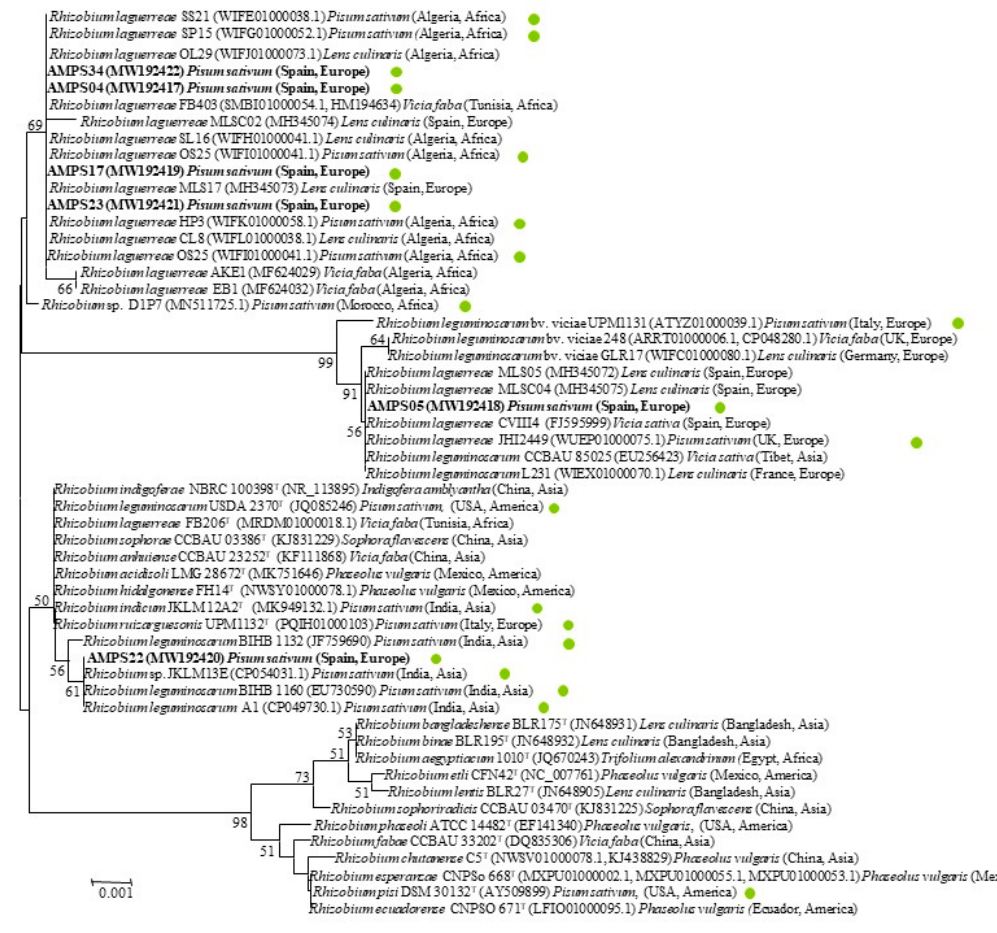
Figure2. Neighbor-joiningunrootedphylogenetictreebasedon rrs genesequences(1340nt)showingthe Figure 2. Neighbor-joining unrooted phylogenetic tree based on rrs gene sequences (1340 nt) taxonomic location of representative strains from di ff erent groups of RAPD within the genus Rhizobium . showing the taxonomic location of representative strains from different groups of RAPD within the Bootstrap values calculated for 1000 replications are indicated. Bar: 1 nt substitution per 1000 nt. genus Rhizobium . Bootstrap values calculated for 1000 replications are indicated. Bar: 1 nt Filled green circles indicated the strains isolated from Pisum sativum substitution per 1000 nt. Filled green circles indicated the strains isolated from Pisum sativum worldwide.